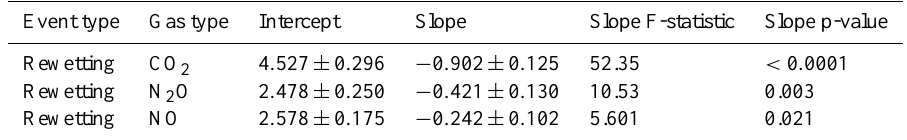
Table 4. Summary statistics of relationship between mean pre-change flux and flux change (i.e. peak flux as a percentage of pre-event flux) by gas and rewetting or thawing (Fig. 5).